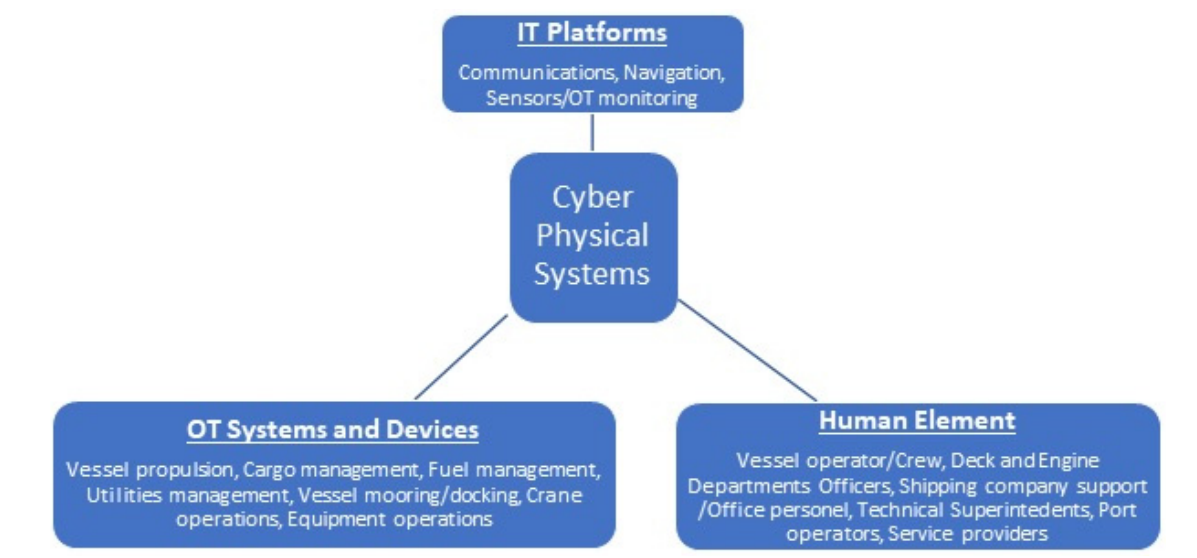
Figure 1. IT, OT, and human element interface in cyber physical systems.